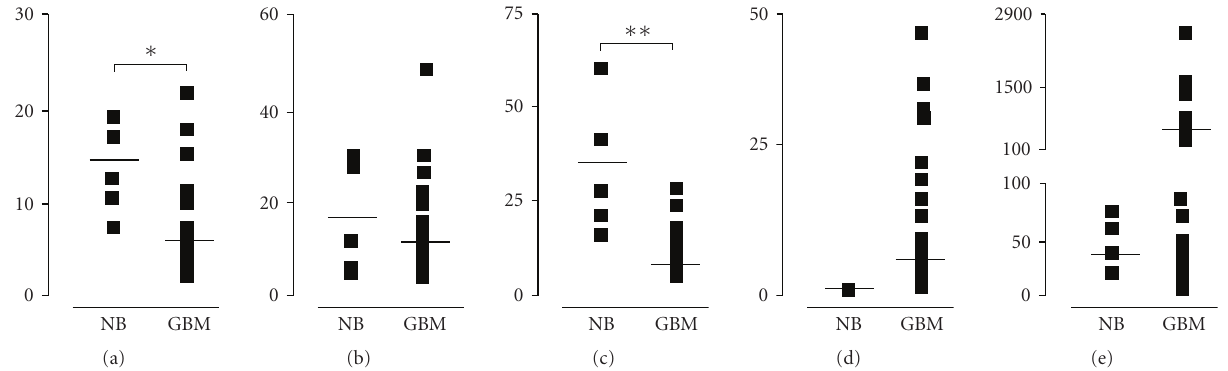
Figure 1: The mRNA expression levels of (a) ADAM17 , (b) HB-EGF , (c) PTEN , (d) MMP9 , and (e) EGFR in 37 human glioblastoma samples (GBM) and in five normal brain cortex samples (NB). Horizontal lines represent the mean values. ∗ P < . 002, ∗∗ P < . 0001.